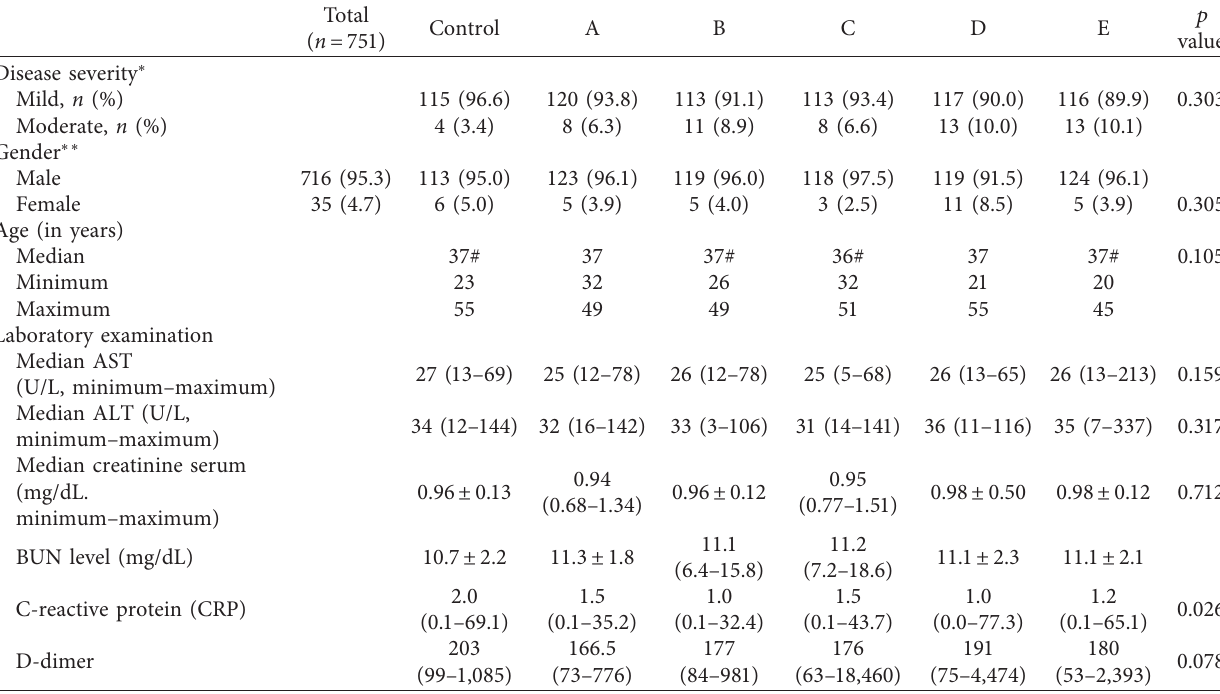
Table 1: The baseline physical characteristics and clinical laboratory data of enrolled subjects who completed treatment during the